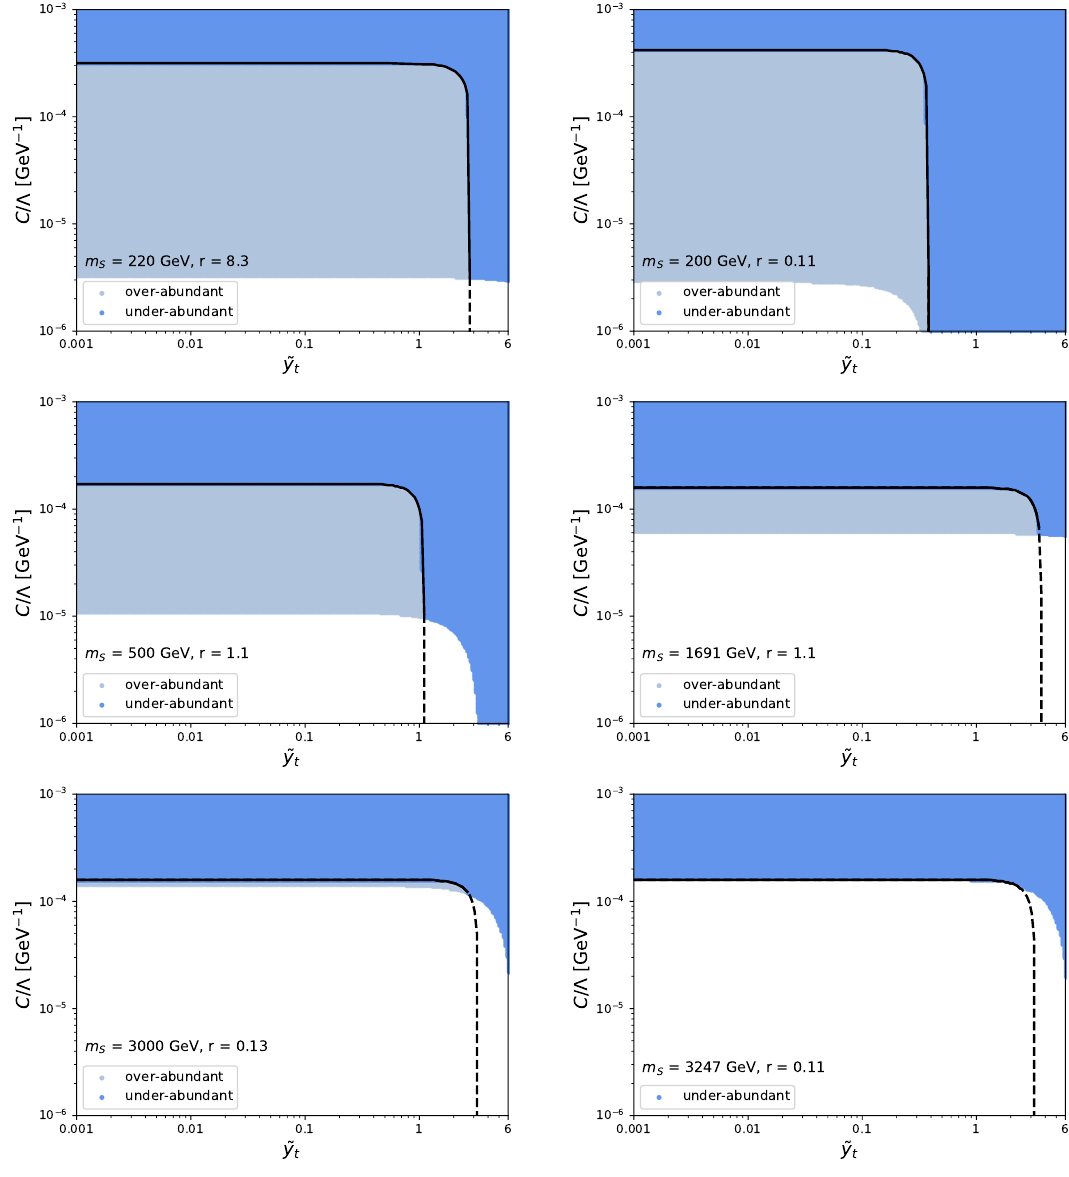
Figure 5 . Six classes of benchmarks illustrating a variety of regimes. These include compressed, split, light, and heavy mass points. The blue area denotes the area in the ( C/ Λ , ˜ y t ) plane which corresponds to a DM-proton cross section which is larger than the neutrino floor (these points do not necessarily correspond to the correct relic density). The relationship between the two parameters which leads to the correct relic density Ω DM h 2 = 0.1186 ± 0.0020 is shown as a black line, where the solid line corresponds to the parameter space lying above the neutrino floor, and the dashed line represents points hidden below the neutrino